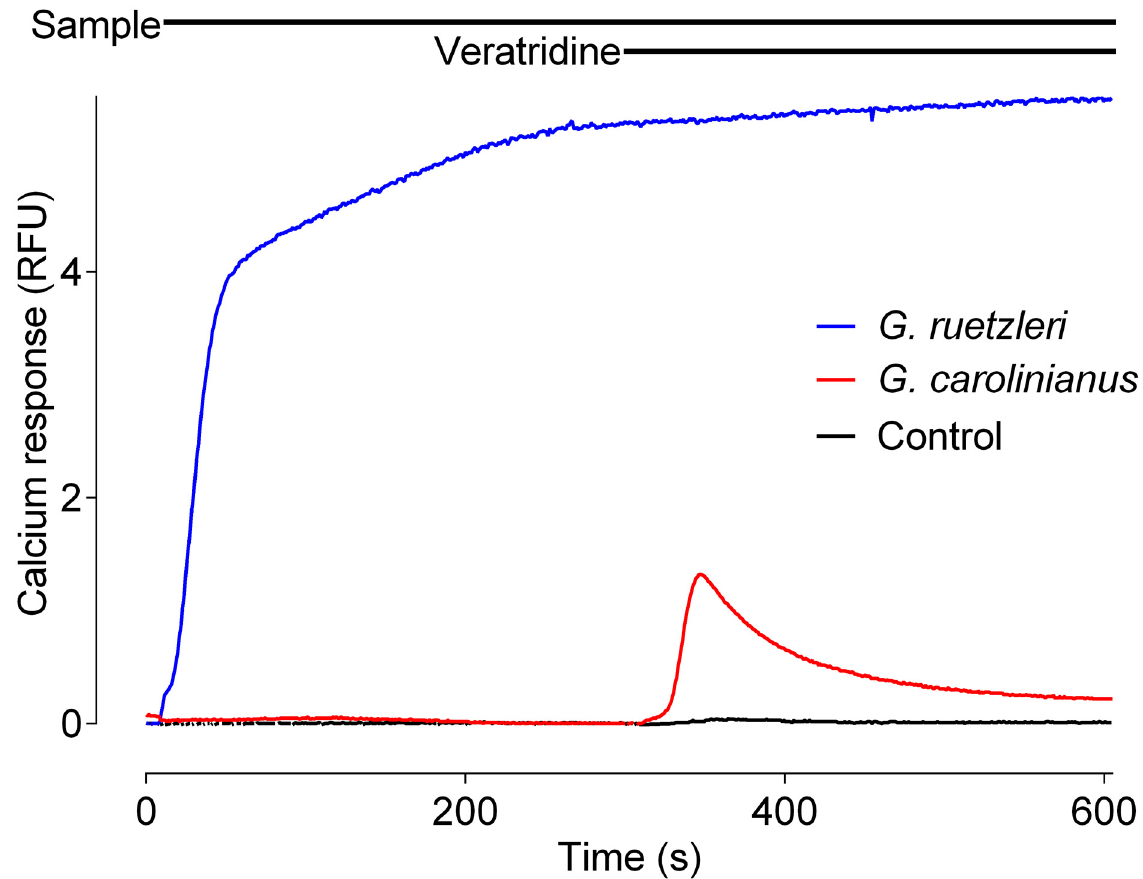
Fig 2. Fluorescence response of SH-SY5Y cells to MTX-like or CTX-like activity. Fluorescent responses to addition of HPLC fractionated samples was measured in SH-SY5Y cells loaded with Calcium-4-NW dye using a two-addition protocol. The presence of MTX-like activity (blue trace, Fukuyoa ruetzleri methanol fraction) caused a rapid increase in fluorescence that was maintained for the 600 s time course. In contrast, addition of samples containing CTX-like activity (red trace, Gambierdiscus carolinianus DCM fraction) caused no measurable increase in fluorescence until addition of veratridine (5 μ M) after 300 s due to potentiation of veratridine-induced effects on endogenous Na V channels by CTX-like activity. The resultant Ca 2+ transient is proportional to the toxicity of CTX-like compounds present. The black trace indicates the buffer control response on the first addition as well as the veratridine response (5 μ M) on second addition in the absence of pre-treatment with CTX.